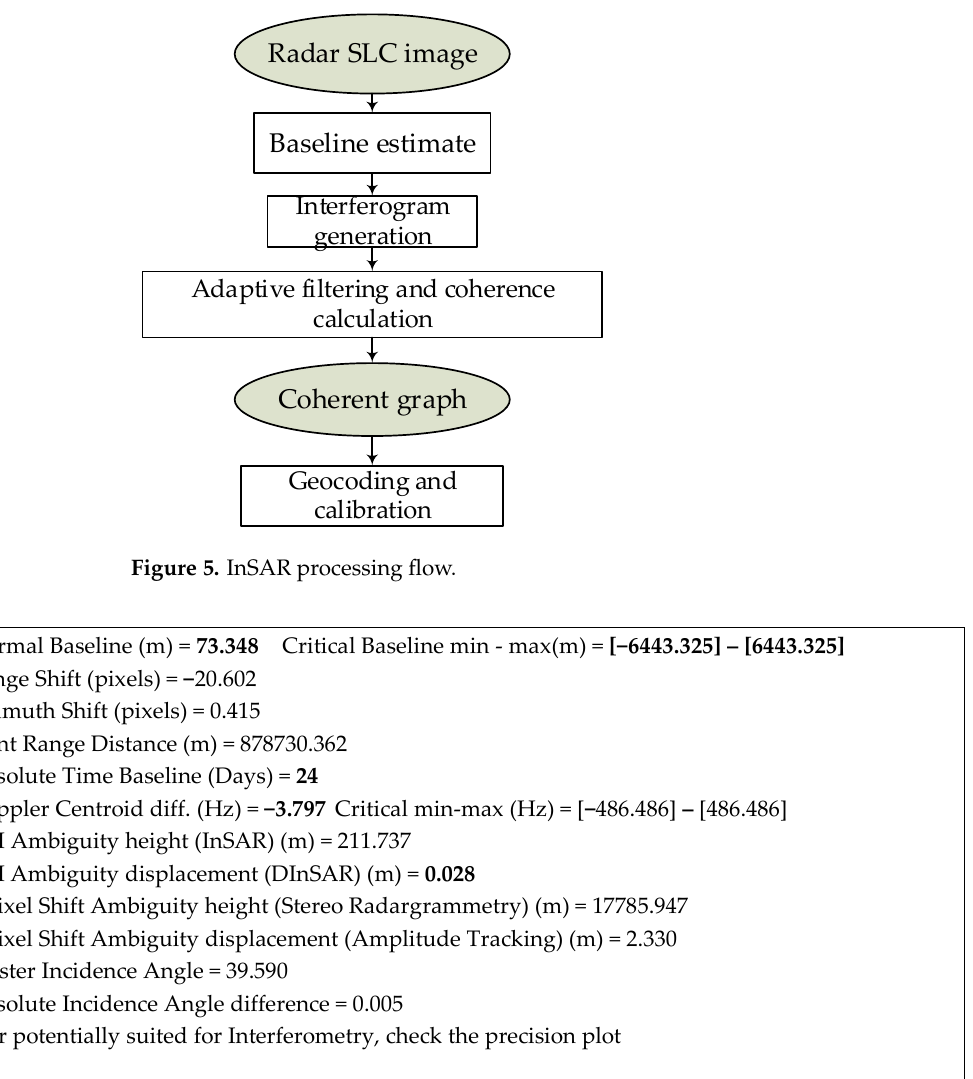
Figure 7. Relationship diagram between Sentinel-1 elevation accuracy and coherence. Figure 8. Relationship diagram between Sentinel-1 deformation accuracy and coherence.